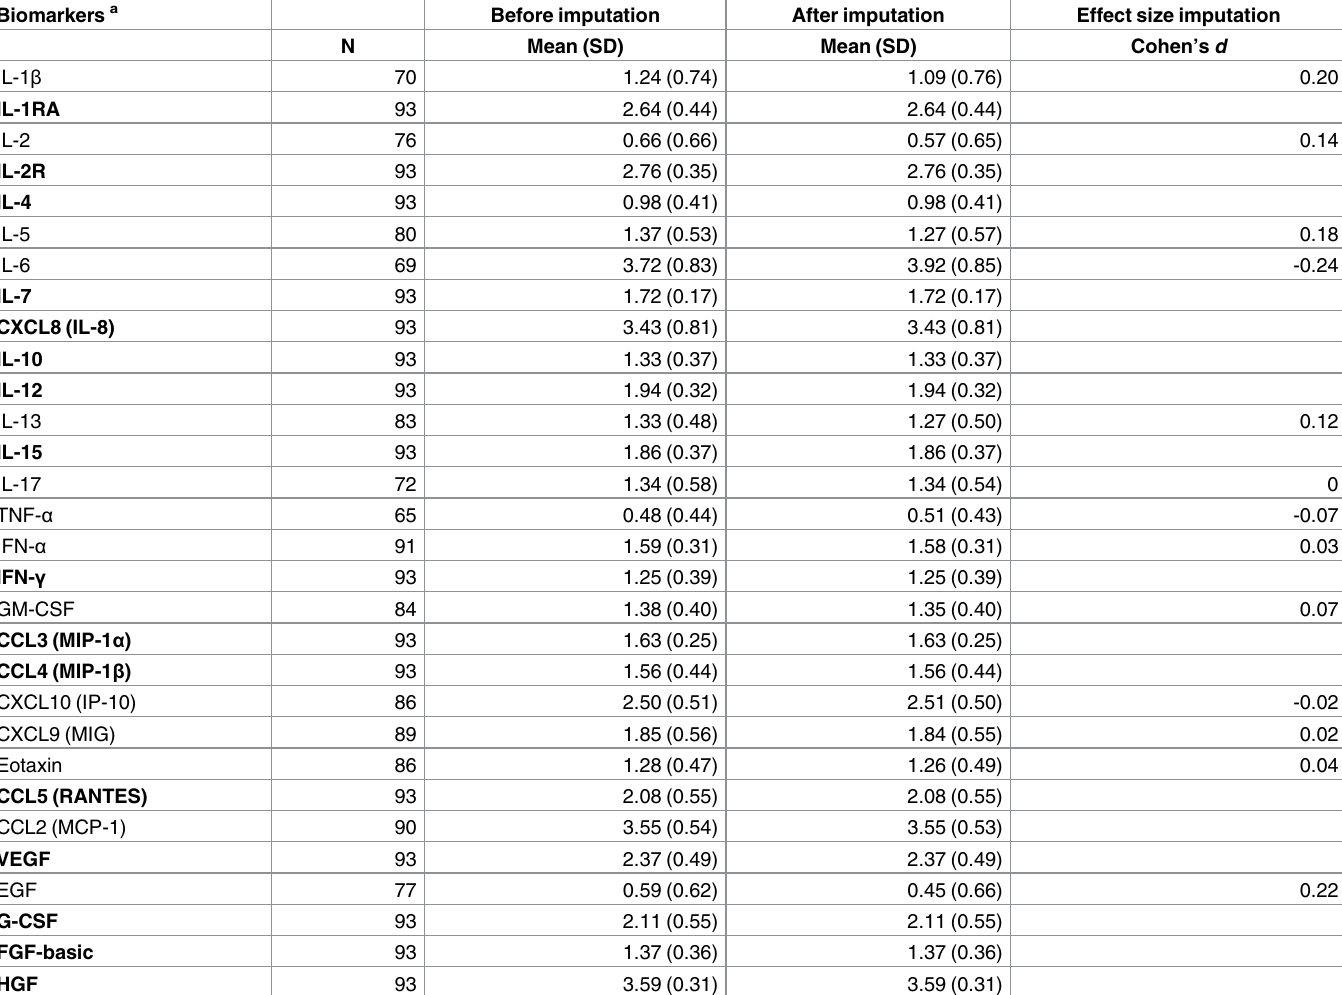
Table 2. Concentration of biomarkers (log pg/mL) in CSDH fluid samples before and after the imputation of missing data.